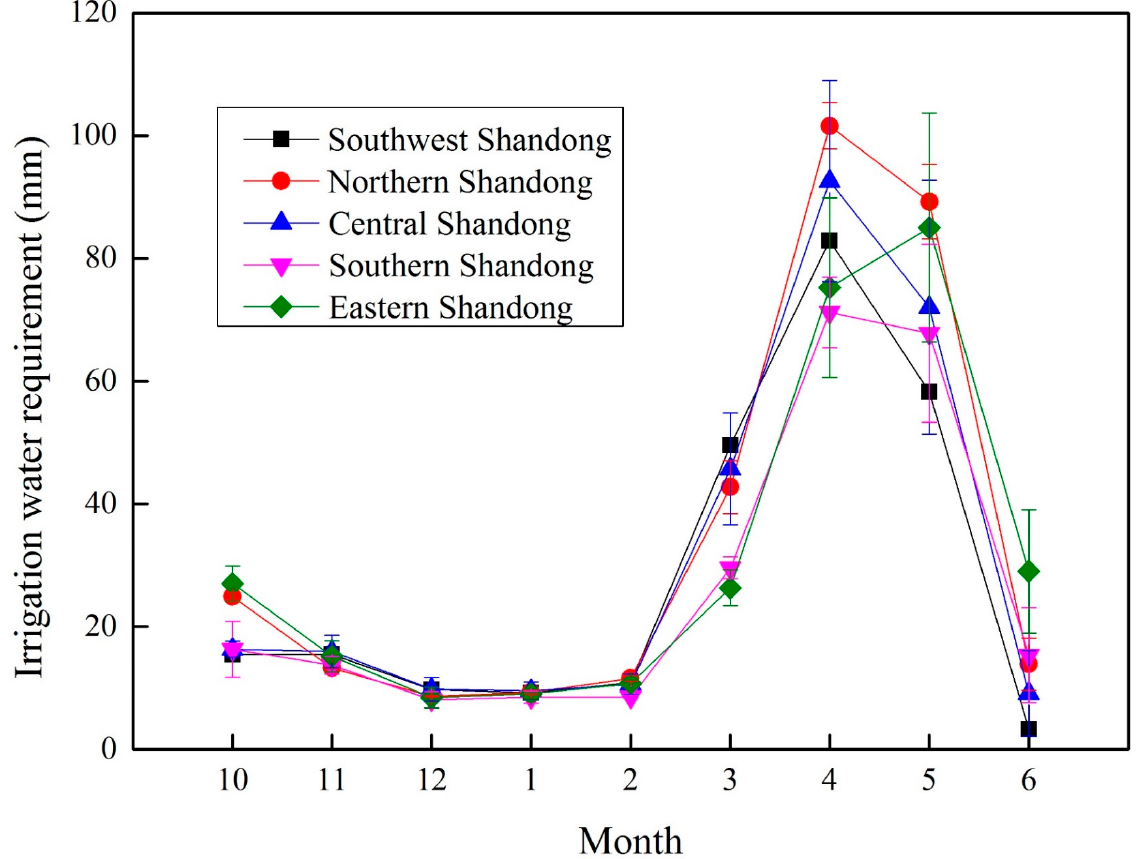
Figure 5. Irrigation water requirements for winter wheat over its growth period. Note: The error bars are standard deviations, and the values are monthly averages.